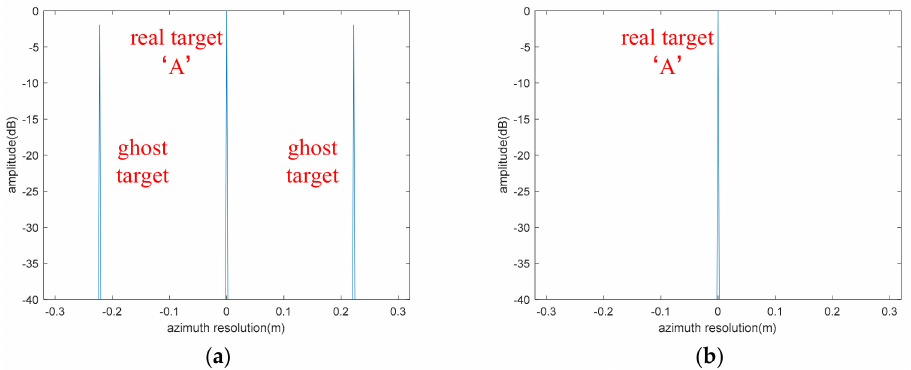
Figure 10. Azimuth profiles of targets in the red dashed boxes in Figure 9. ( a ) Without compensation and ( b ) with